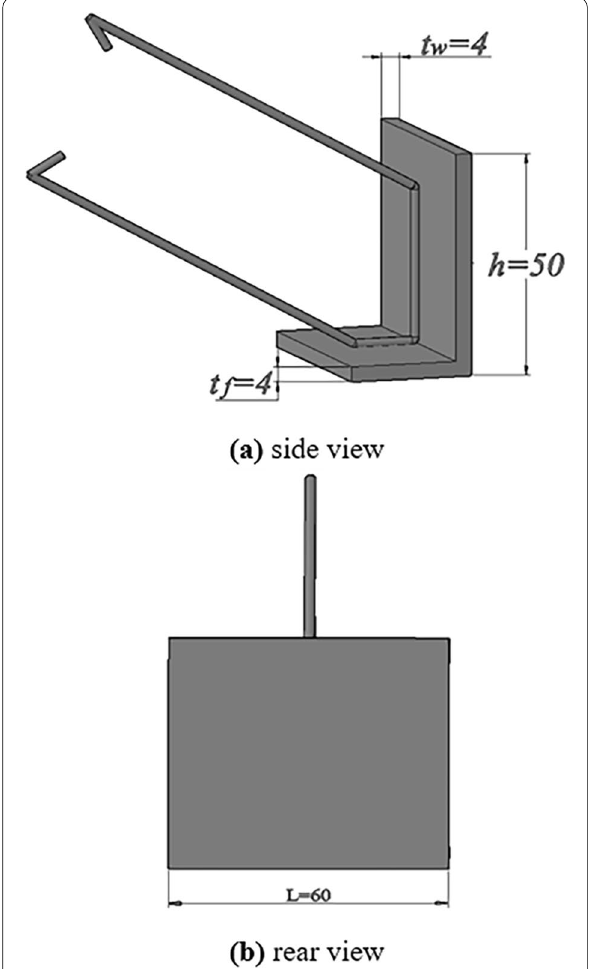
Fig. 1 Angle connector: a side view, b rear